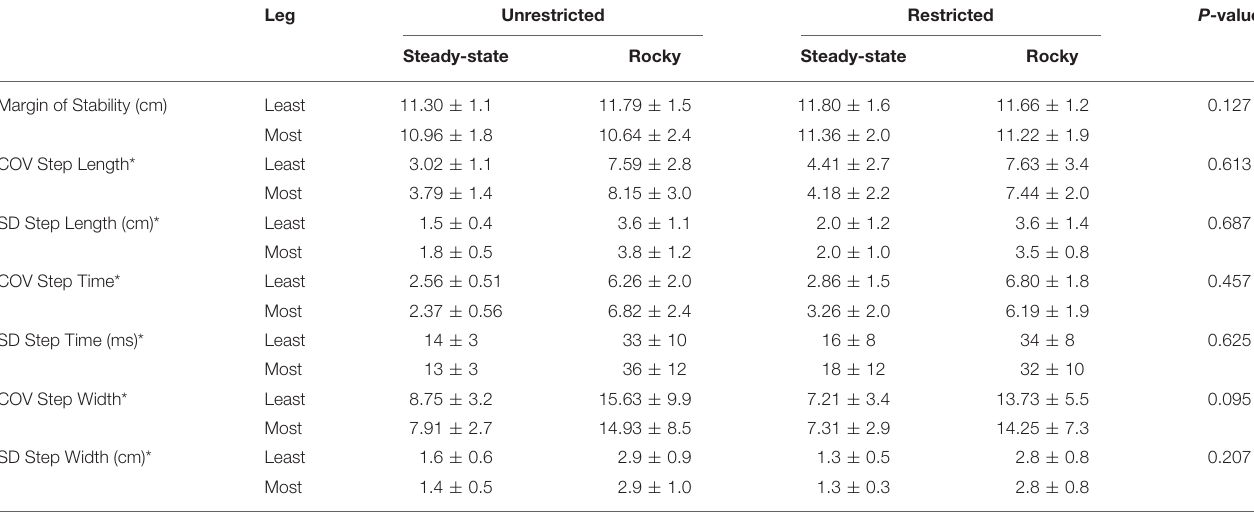
TABLE 2B | Dynamic Stability Measures for arm (unrestricted and restricted) and terrain (steady-state and rocky) conditions: Margin of Stability and Coefficient of Variation and Standard Deviation for Step Time, Length, and Width. Leg Unrestricted Restricted P -value Steady-state Rocky Steady-state Rocky Margin of Stability (cm)